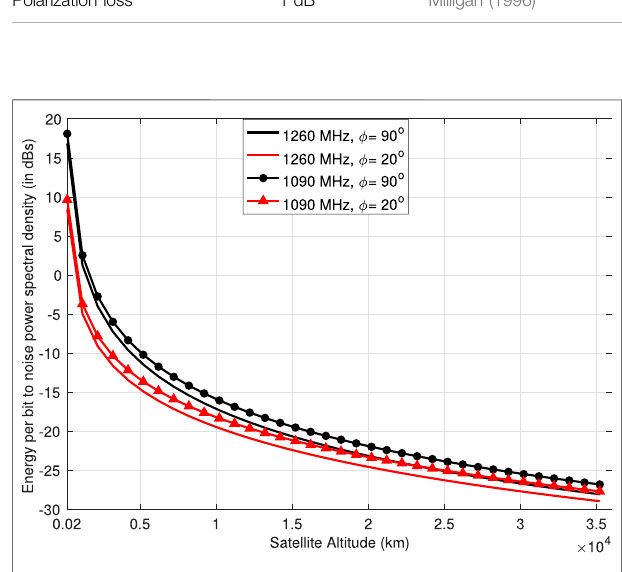
FIGURE 9 | Energy-per-bit to noise spectral density for the satellite-to- eVTOL link at varying frequencies, altitudes, and elevation angles.